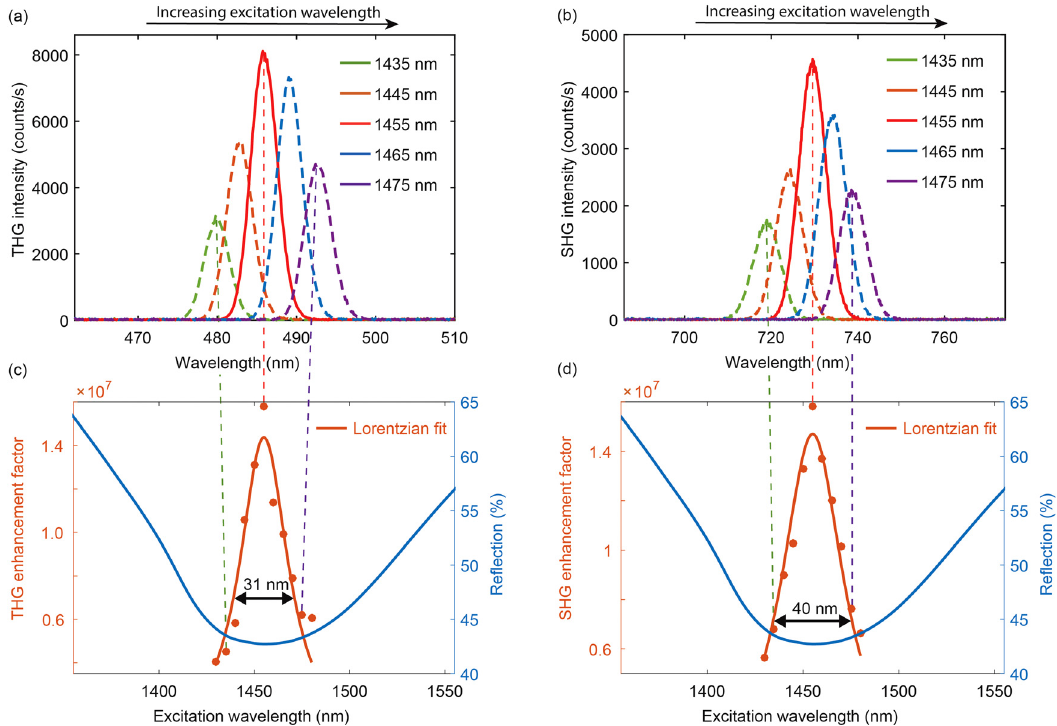
Figure3: (a)THGresponsespectraasafunctionofexcitationwavelength.(b)SHGresponsespectraasafunctionofexcitationwavelength.(c) THG enhancement factor as a function of excitation wavelength (red) compared to the reflection spectrum (blue) which shows the plasmon resonance. The full widths at half maximum(FWHM) of the THG enhancement is 31 nm. (d) SHG enhancement factor as a function of excitation wavelength (red) compared to the re fl ection spectrum (blue) which shows the plasmon resonance. The FWHM of the SHG enhancement is 40 nm, while the FWHM of the re fl ection spectrum is 204 nm in both (c) and (d). THG, third-harmonic generation; SHG, second-harmonic